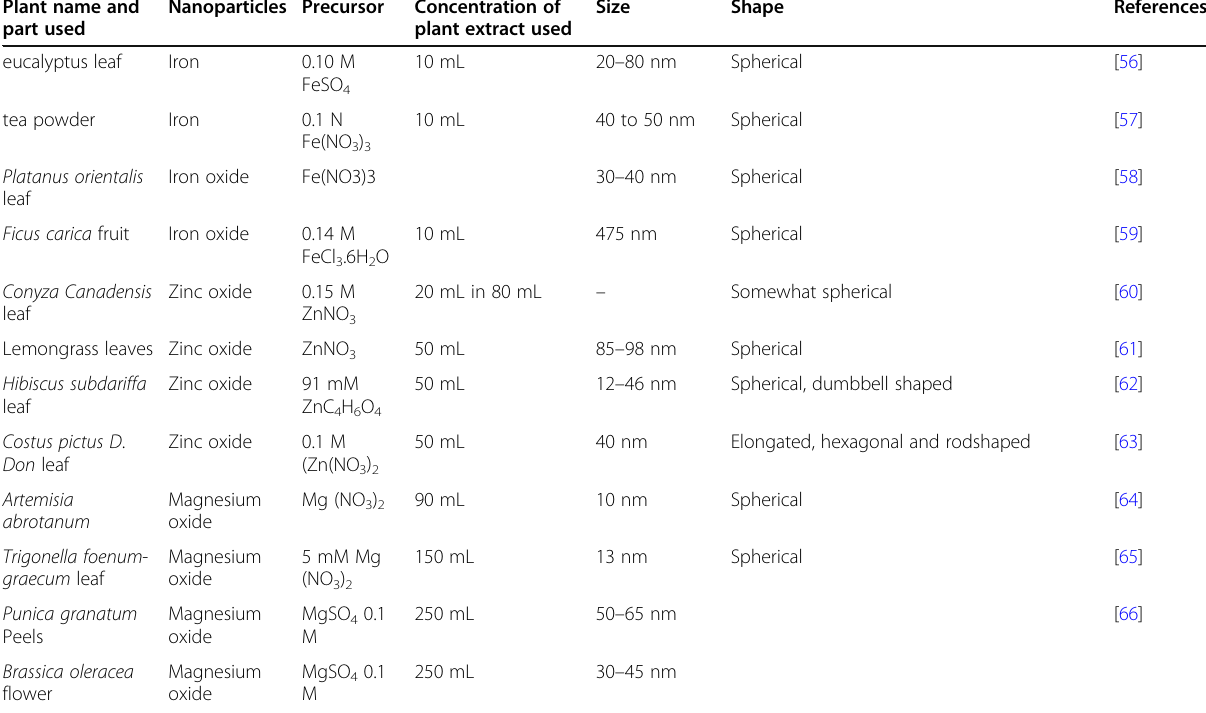
Table 1 Effect of biological material, precursor concentration and extract concentration on the morphology of biological nanoparticles (Continued)